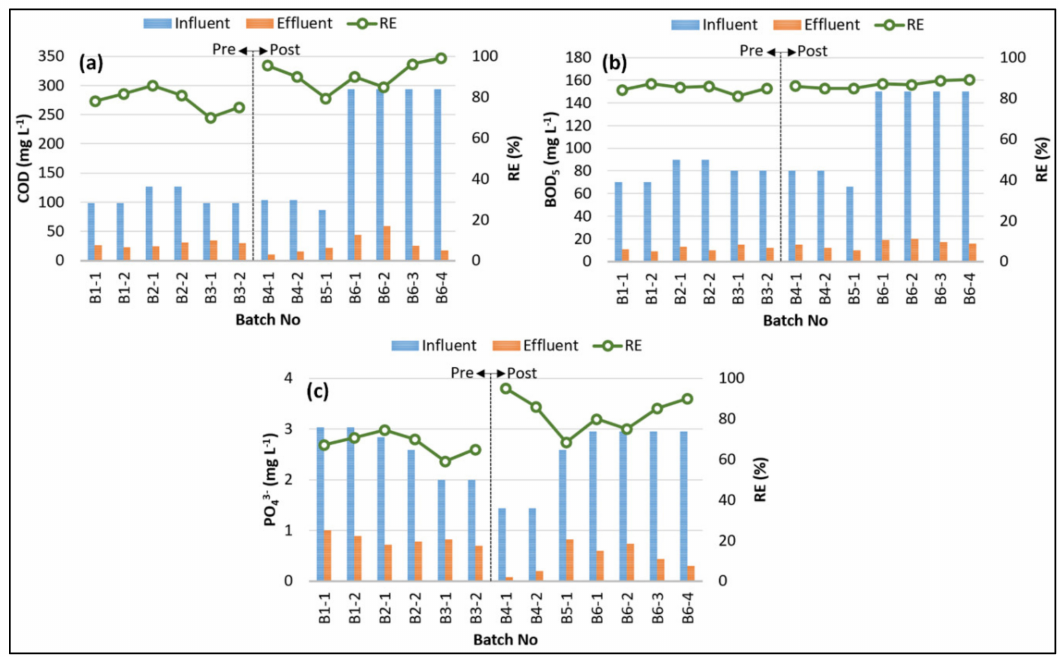
Figure 3. Variations and removal e ffi ciencies of ( a ) the chemical oxygen demand (COD), ( b ) the 5-day biological oxygen demand (BOD 5 ), and ( c ) phosphate (PO 43 −